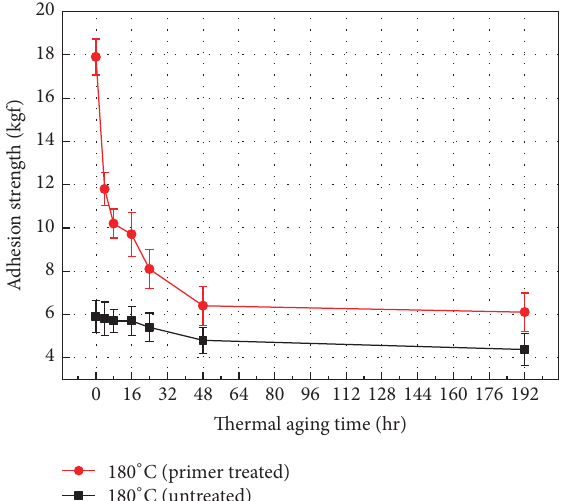
Figure 9: Adhesion properties of thermal aging at 180 ∘ C with and without primer